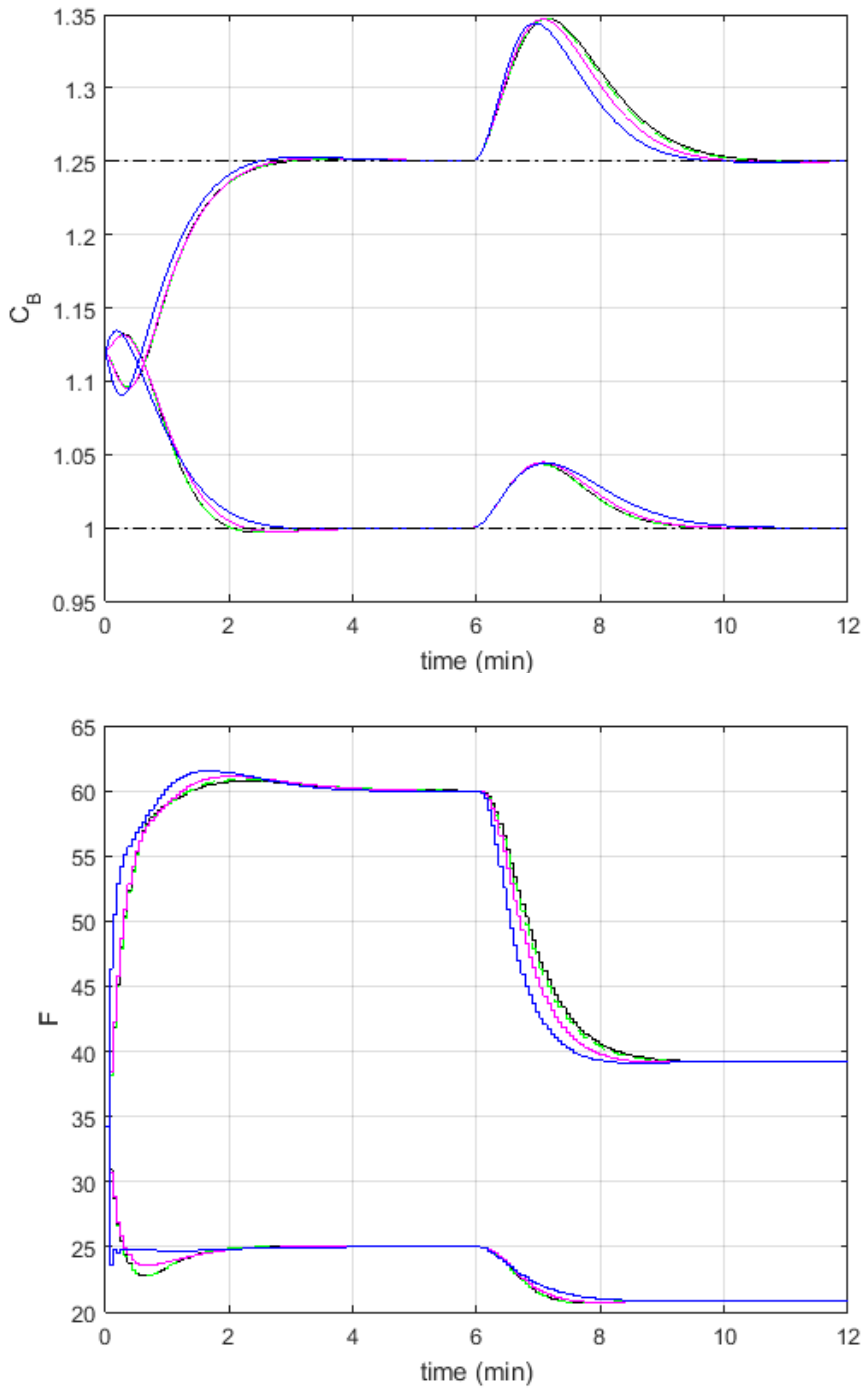
Figure 5. Responses of the control system with FMPC1 algorithm and λ = 0.001 to changes in the setpoint to C B 1 = 1 mol/L and C B 2 = 1.25 mol/L and to the change of the disturbance by 10% in the 6th minute of the experiment; s = 35—black lines, s = 10—green dashed lines, s = 5—magenta lines, s = 1—blue